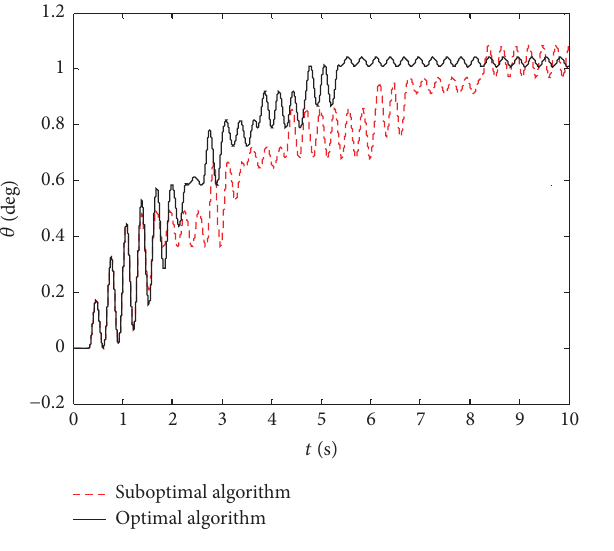
Figure 5: History between 𝜃 and 𝑡 . Figure 6: History between impulsive thruster 𝑃 and 𝑡 .